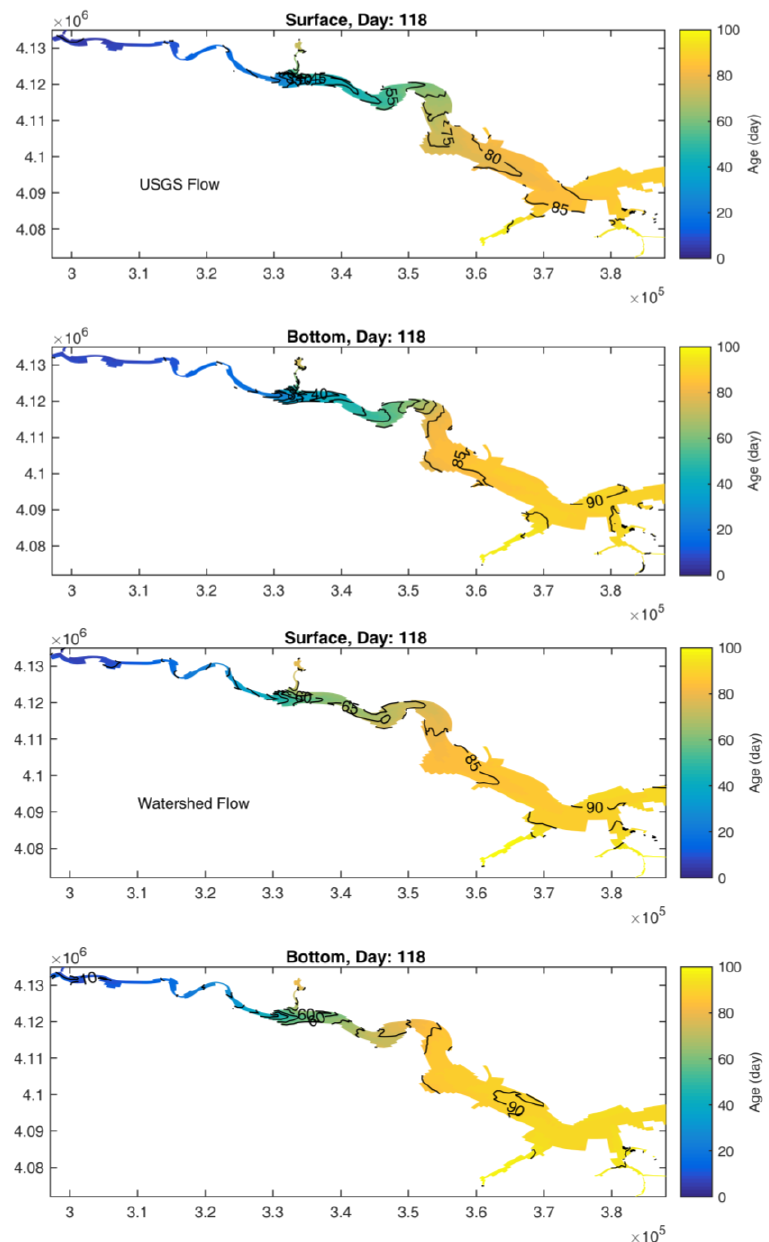
Figure 10. An example of water age at 16 April 2008 (the left panel shows results using watershed flow, and the right panel shows results using USGS flow).